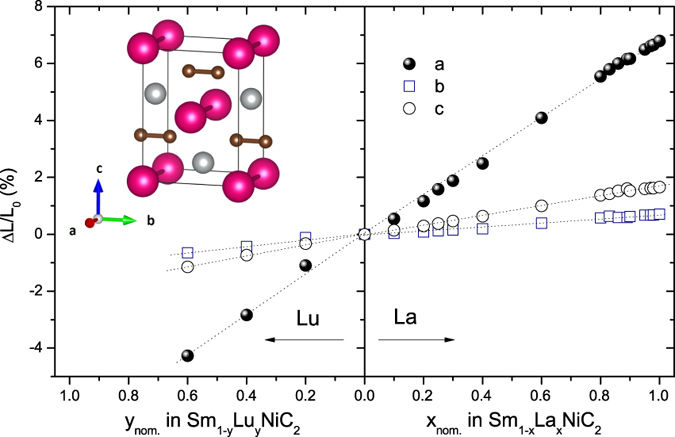
Relative change in lattice parameters: ΔL/L0 = (Lx−L0)/L0 and ΔL/L0 = (Ly−L0)/L0 for La and Lu doped samples, respectively.The lattice parameter along the a-axis (solid circles) shows the maximal change. Inset shows the crystal structure of SmNiC2. Samarium and nickel atoms are represented by purple and grey balls, respectively. Small carbon atoms are marked by brown balls. Note that the C-C dimers are located along the b – axis.